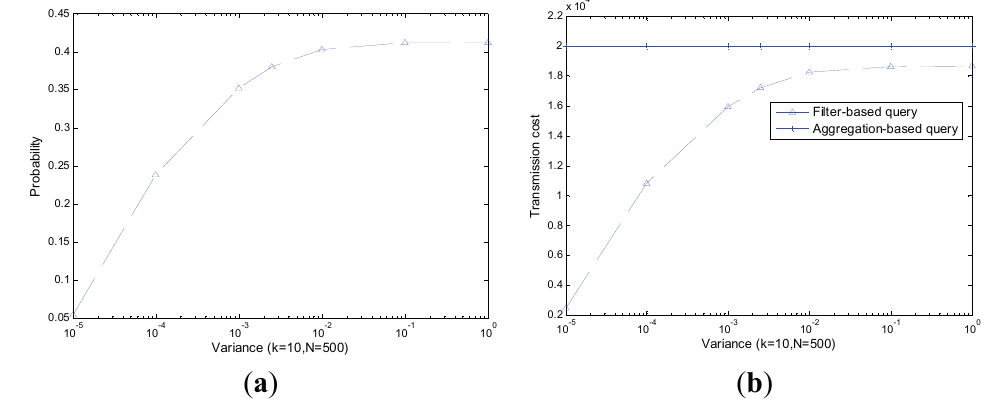
Figure 10. (cid:1842)(|leave| > |join|) and corresponding transmission cost with different ( a ) (cid:1842)( |leave| > |join| ) ; ( b ) Transmission + (cid:1848)(cid:1853)(cid:1870) (cid:1848)(cid:1853)(cid:1870) (cid:3036)(cid:2879)(cid:3032)(cid:3045)(cid:3045) (cid:3036)(cid:2879)(cid:3043)(cid:3035)(cid:3052)